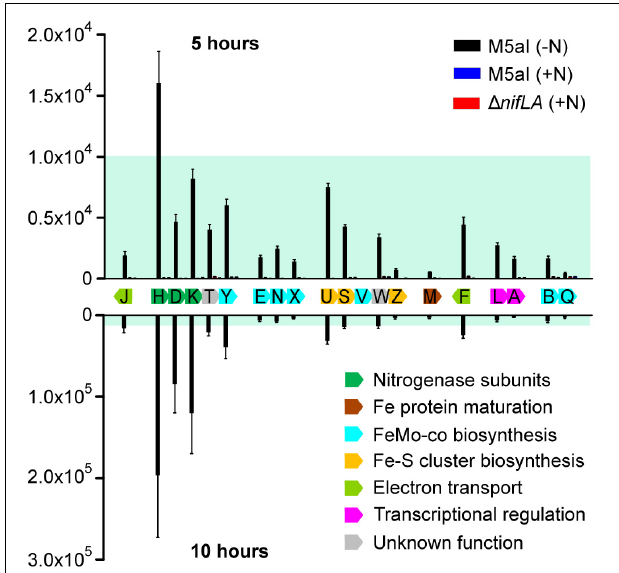
FIGURE 4 | Stoichiometry of Nif proteins during the onset of diazotrophy. Absolute copy number of 19 detectable Nif proteins at the onset of nitrogen starvation (5 h following supplementation with 0.5 mM NH4; above the x -axis) and at the onset of slow diazotrophic growth (10 h; below the x -axis) in Ko M5a1 wild-type cells (black bars). N-replete conditions (wild-type plus 10 mM NH 4 Cl; blue bars) and Nif– ( (cid:49) nifLA ; red bars) cells were used as negative controls, which are barely visible in the figure. Protein samples were supplemented with heavy-labelled QconCAT standards (QNif1, QNif2, QNif3) prior to tryptic digestion. Multiple peptide transitions per Nif protein (see Supplementary Data 1 ) were integrated for calculation of absolute protein copy number per cell. Estimates inferred from known QconCAT